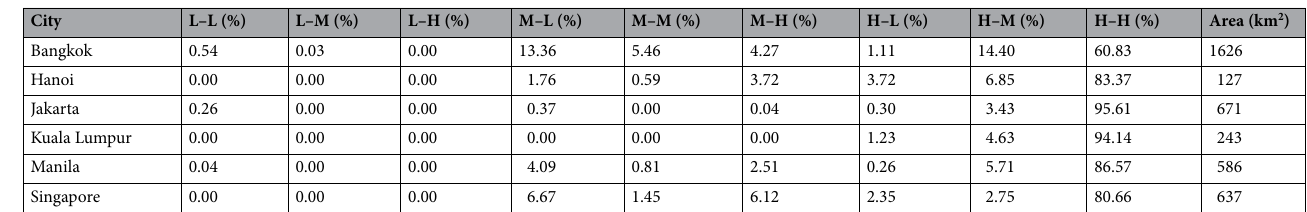
Table 1. Percentage of rural–urban classification in six capitals cities of Southeast Asia countries. With L = Low, M = Medium, H = High.